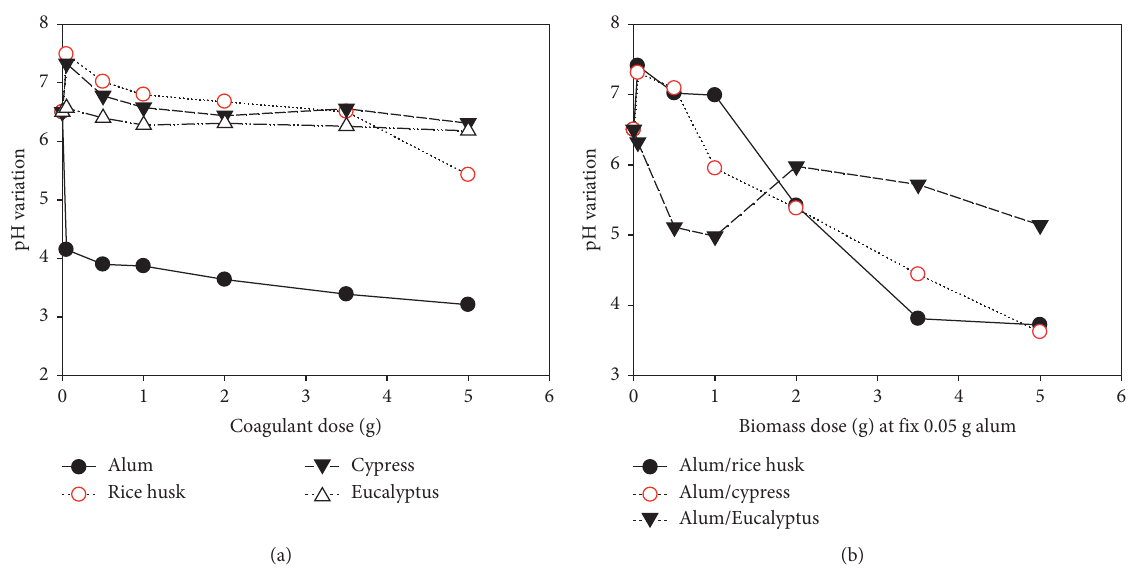
Figure 9: Variation of pH in M90 water with (a) individual and (b) mixed